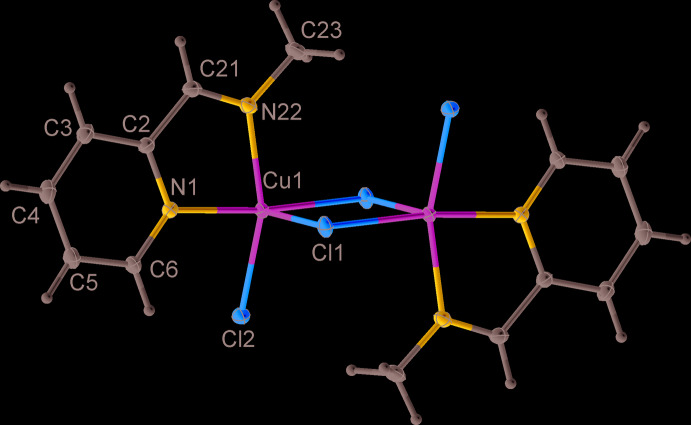
Mol­ecular structure and principal labelling of [CuLCl2]2 (I) with ellipsoids at the 50% probability level.